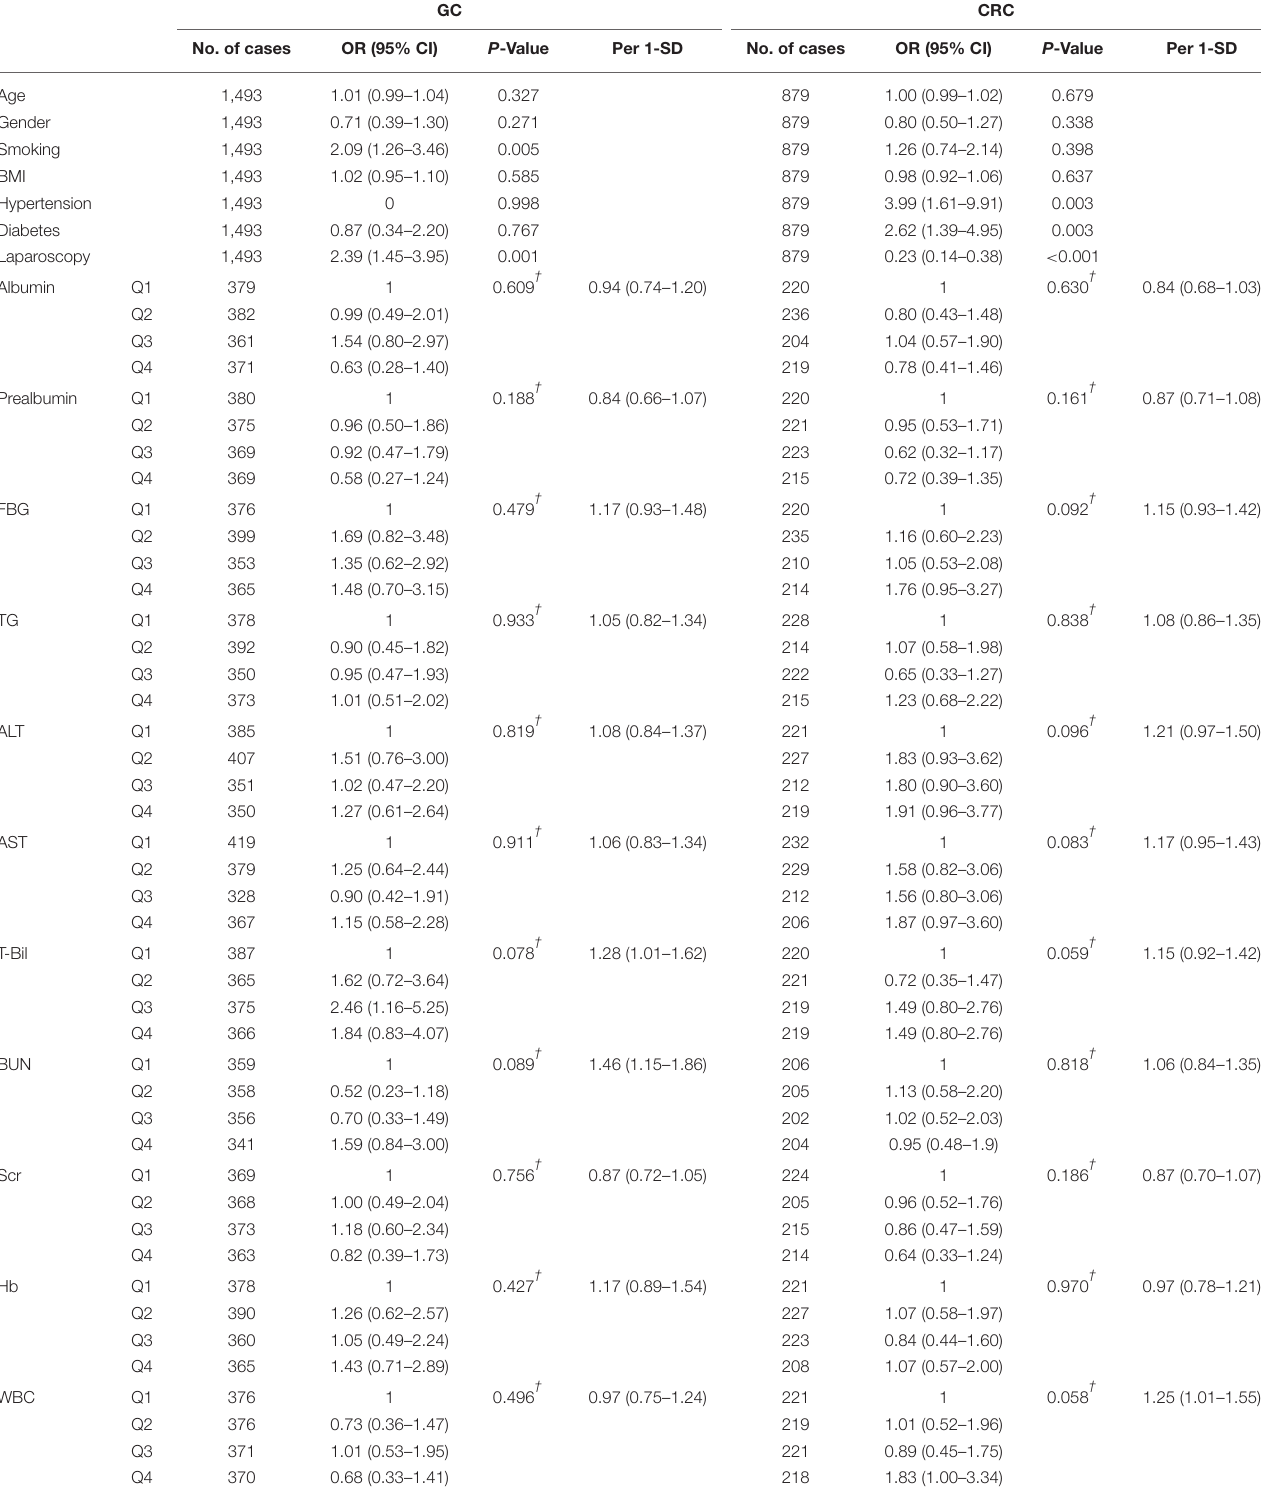
TABLE 2 | The association of clinical characteristics and hematologic biomarkers with post-operative